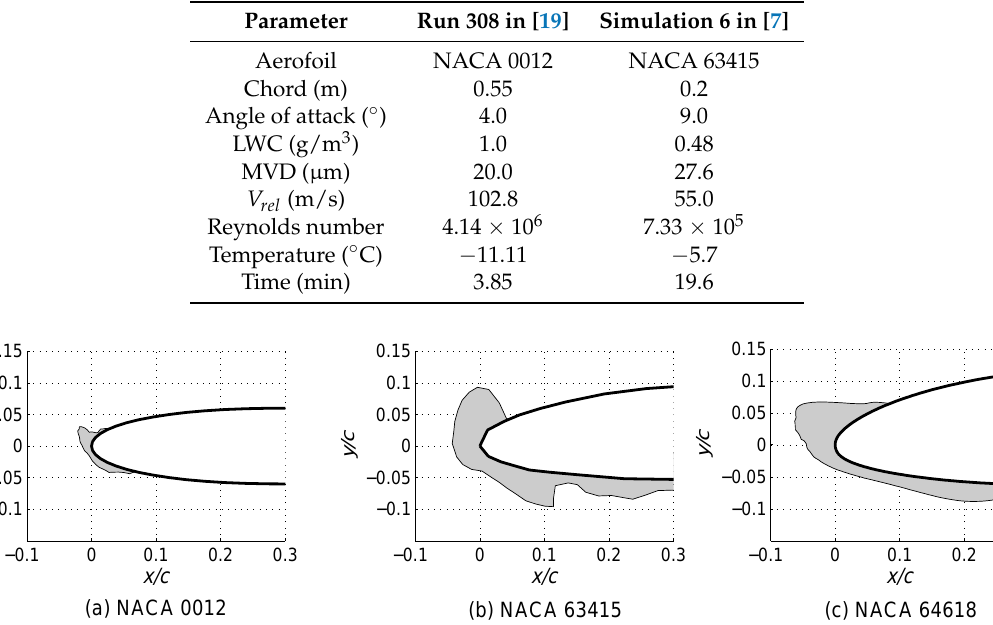
Figure 1. Ice shapes on the aerofoil sections ( a ) simulated in [19], ( b ) simulated in [7], ( c ) curve fitted in this